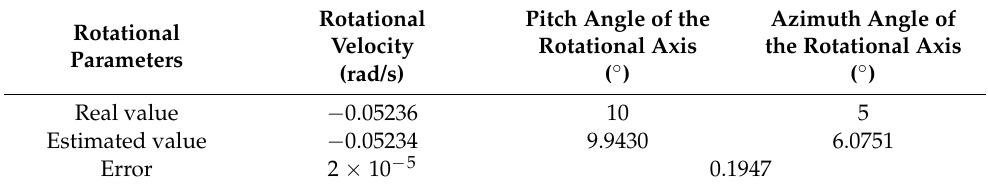
Table 4. Estimation result of rotational parameters of ENVISAT.